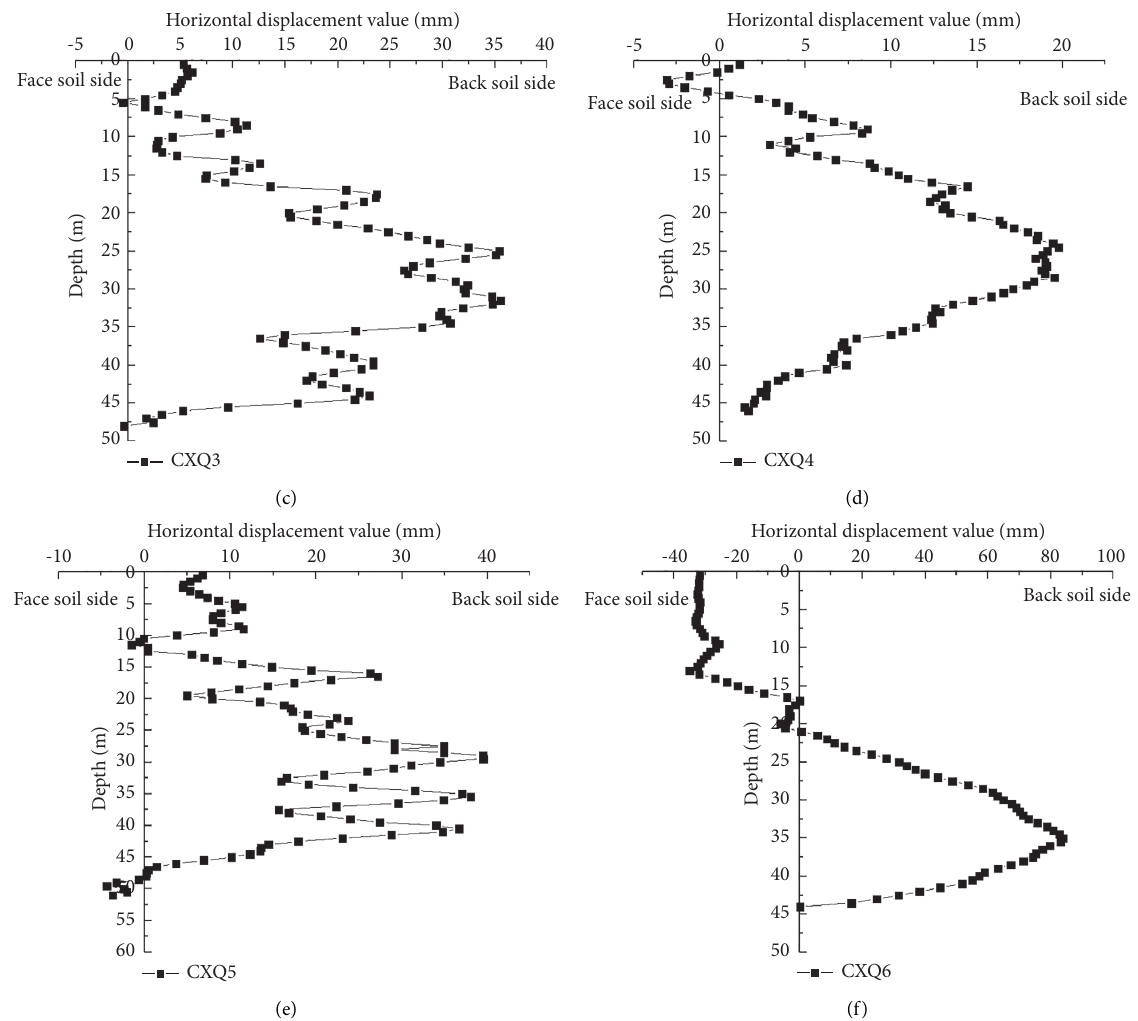
Figure 24: Variation curve of deep horizontal displacement of the diaphragm